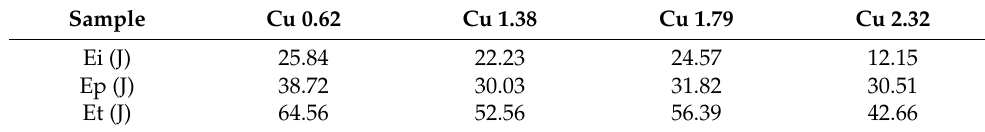
Figure 8. Mechanical properties of deposited metals. ( a ) Engineering strength ‐ strain curves. The Cu 1.79 obtains the maximum strength value. ( b ) The Charpy V ‐ Notch impact load curves (solid lines) and impact energy curves (dotted lines). Table 3. Crack initiation energy (Ei) and crack propagation energy (Ep) of deposited metals.